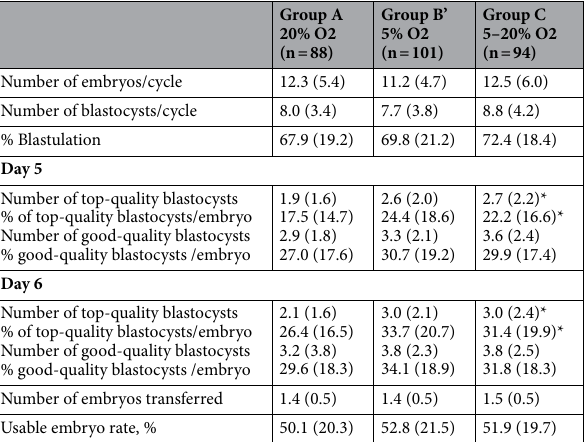
Table 3. Comparison of biological outcomes between groups A, B’ and C (20% vs. 5–5% vs. 5–20% O2, respectively). Data are presented as mean (SD). * Global P -value < 0.05.